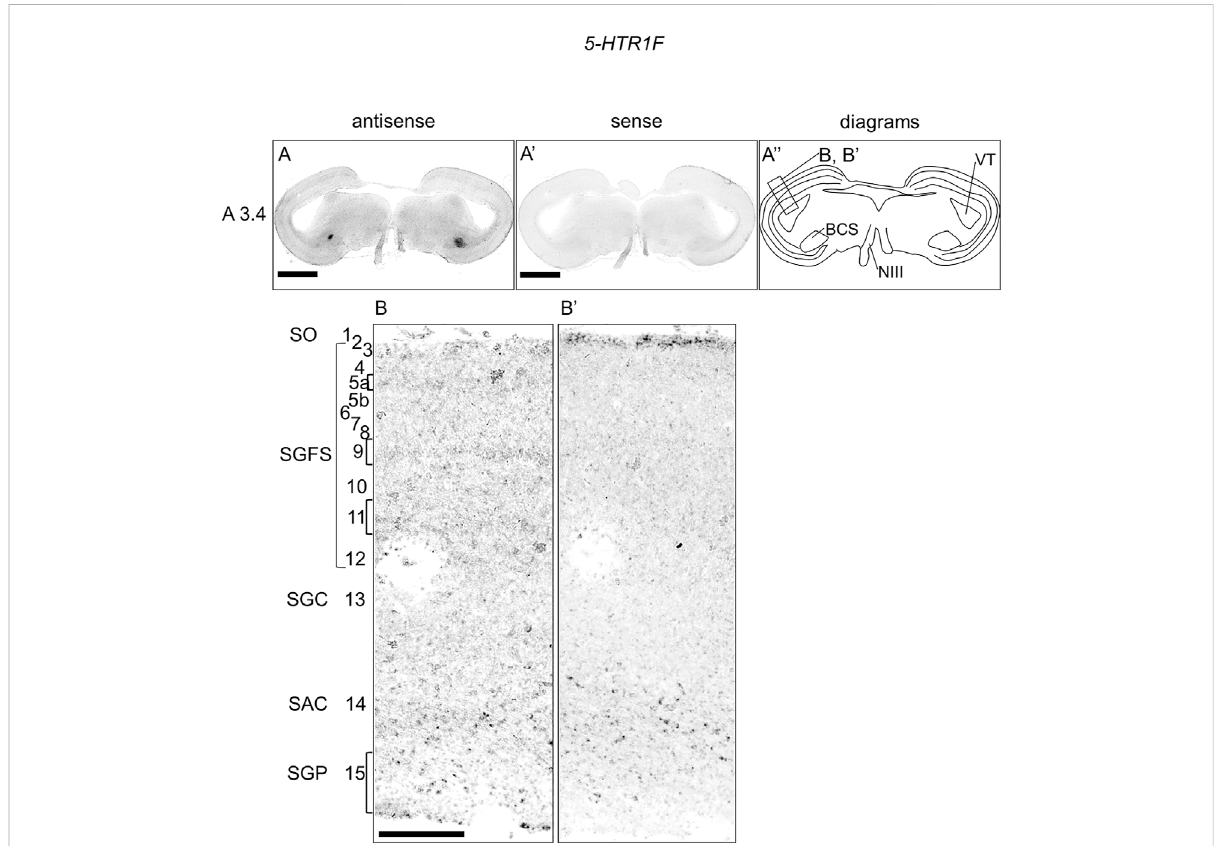
FIGURE 4 Insitu hybridizationof 5-HTR1F intheP1chickbrainstem.Digoxigenin-labeledRNAantisense (A,B) andsense (A 9 ,B 9 ) 5-HTR1F probeswereused for in situ hybridization in coronal sections of P1 chick brainstems. To evaluate the expression patterns of 5-HTR1F , we analyzed sections from three chick brainstems; representative images of chick brain sections are shown. (A 99 ) Diagrams of coronal sections shown in the rightmost panels. The levels of expression in sections (A3.4) were in accordance with those mentioned in the Kuenzel and Masson ’ s chick atlas (Kuenzel and Masson, 1988). (B,B 9 ) Magni fi ed views of the regions of optic tectum. Numbers represent tectal layers according to Ramon y Cajal (Ramon y Cajal, 1911). The leftmost alphabeticalsystem ofnomenclature wasinaccordancewiththat mentioned intheKuenzelandMasson ’ schick atlas(KuenzelandMasson, 1988). BCS, brachium colliculi superiors; NIII, nervus oculomotorius; P1, post-hatch day 1; SAC, stratum album centrale; SGC, stratum griseum centrale;SGFS,stratumgriseumet fi brosumsuper fi ciale;SGP,stratumgriseumperiventriculare;SO,stratumopticum.Scalebars=2.5 mm (A,A 9 ) and 250 µm (B,B 9 )